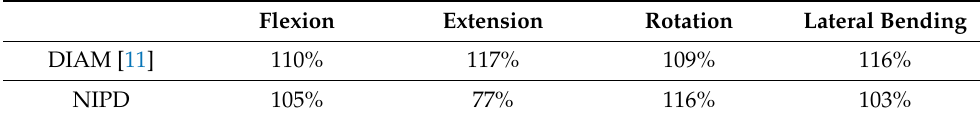
Table 6. Comparison between the NIPD and the current device DIAM in the normalized data in the INT model ([DIAM or NIPD]/INT] ×